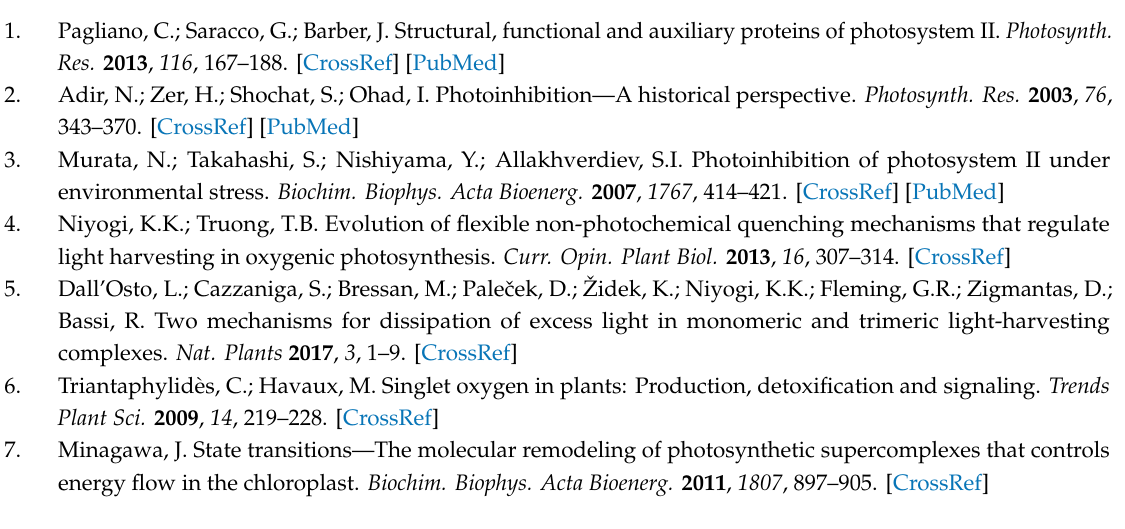
Figure S1. E ff ects of SA on PSI photochemistry in Arabidopsis thaliana under high light. Figure S2. Assays of state transitions in Arabidopsis thaliana under high light in the presence or absence of SA pretreatment. Figure S3. E ff ects of SA on gas exchange parameters in Arabidopsis thaliana under high light. Figure S4. Quantitative data for D1 and PsaD of detached leaves in the presence or absence of SA pretreatment before untreated ( − ) and after lincomycin-treated ( + ) photoinhibition using a light intensity of 1000 µ mol photons m − 2 · s − 1 for 3 h. Figure S5. The SDS-PAGE results after Coomassie blue staining (CBS). Figure S6. Quantitative data for thylakoid protein phosphorylation in Arabidopsis thaliana under high light in the presence or absence of SA pretreatment. Figure S7. Oxidative stress analysis of Arabidopsis thaliana in the presence or absence of SA pretreatment before untreated ( − ) and after lincomycin-treated ( + ) photoinhibition using a light intensity of 1000 µ mol photons m − 2 · s − 1 for 3 h. Figure S8. Quantitative data for transmission electron microscope analysis of chloroplasts in Arabidopsis thaliana under high light in the presence or absence of